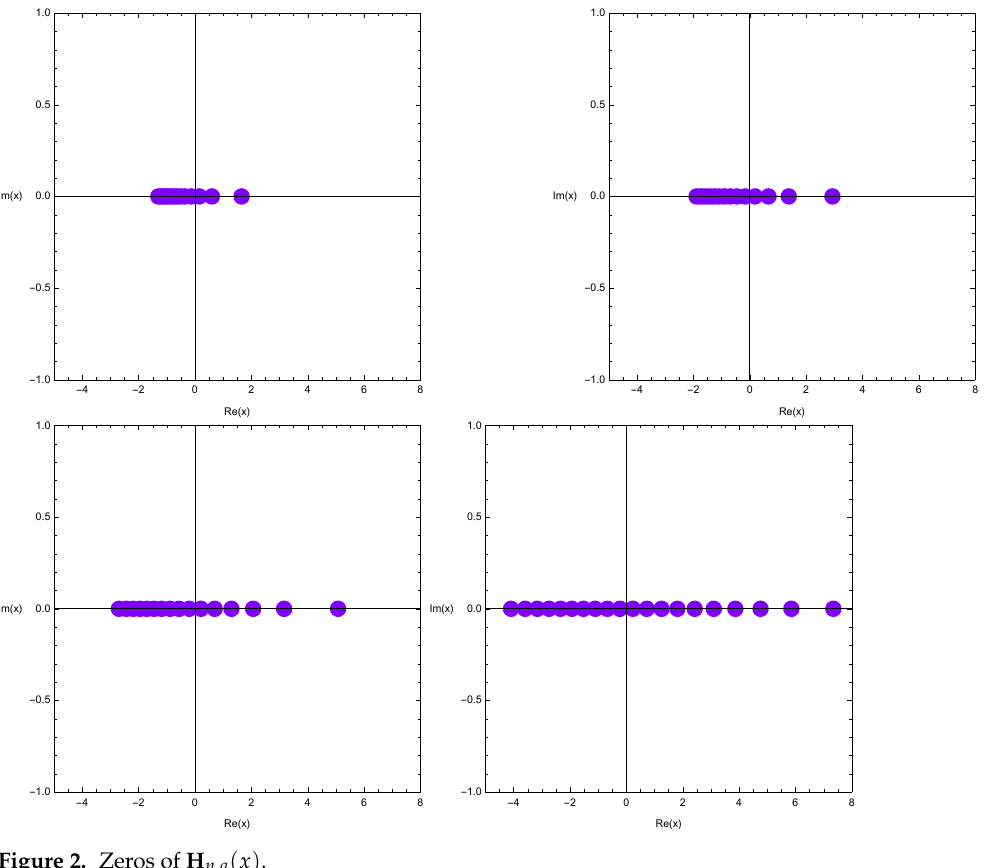
Figure 2. Zeros of H n , q ( x )